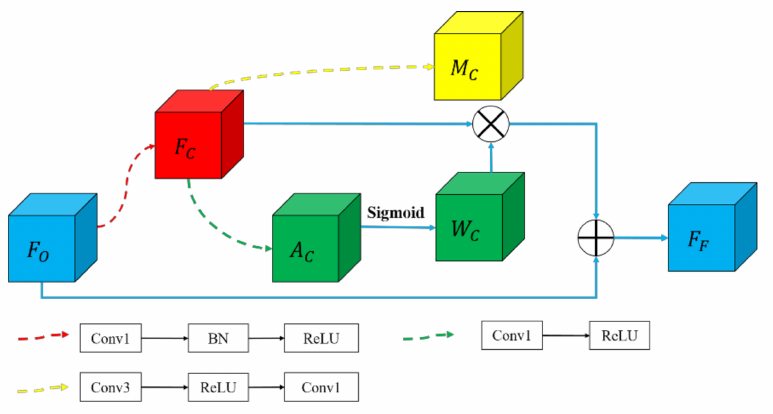
Figure 9. The circumscribed rectangle is not equivalent to the horizontal bounding box. Red box: horizontal bounding box. Green box: rotating bounding box. Blue box: circumscribed rectangle.